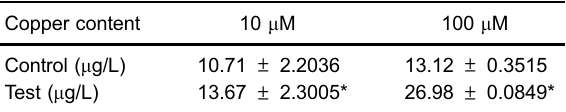
Figure 1. Percentage of viable of HeLa cells at different Cu-His concentrations. Cellular viability was analyzed using the MTT assay. Cu-His at different concentrations (200, 400, 600, 800, and 1000 m M) inhibited cell viability by approximately 20%-50% (P o 0.01, t -test), but not for concentrations under 100 m M (n=8) (P 4 0.05). The results were reported relative to the response of the negative control cells. MTT, 3-(4,5-dimethylthiazol-2-yl)-2,5- diphenyltetrazolium bromide. Table 1. Cellular copper content at different Cu-His concentrations.